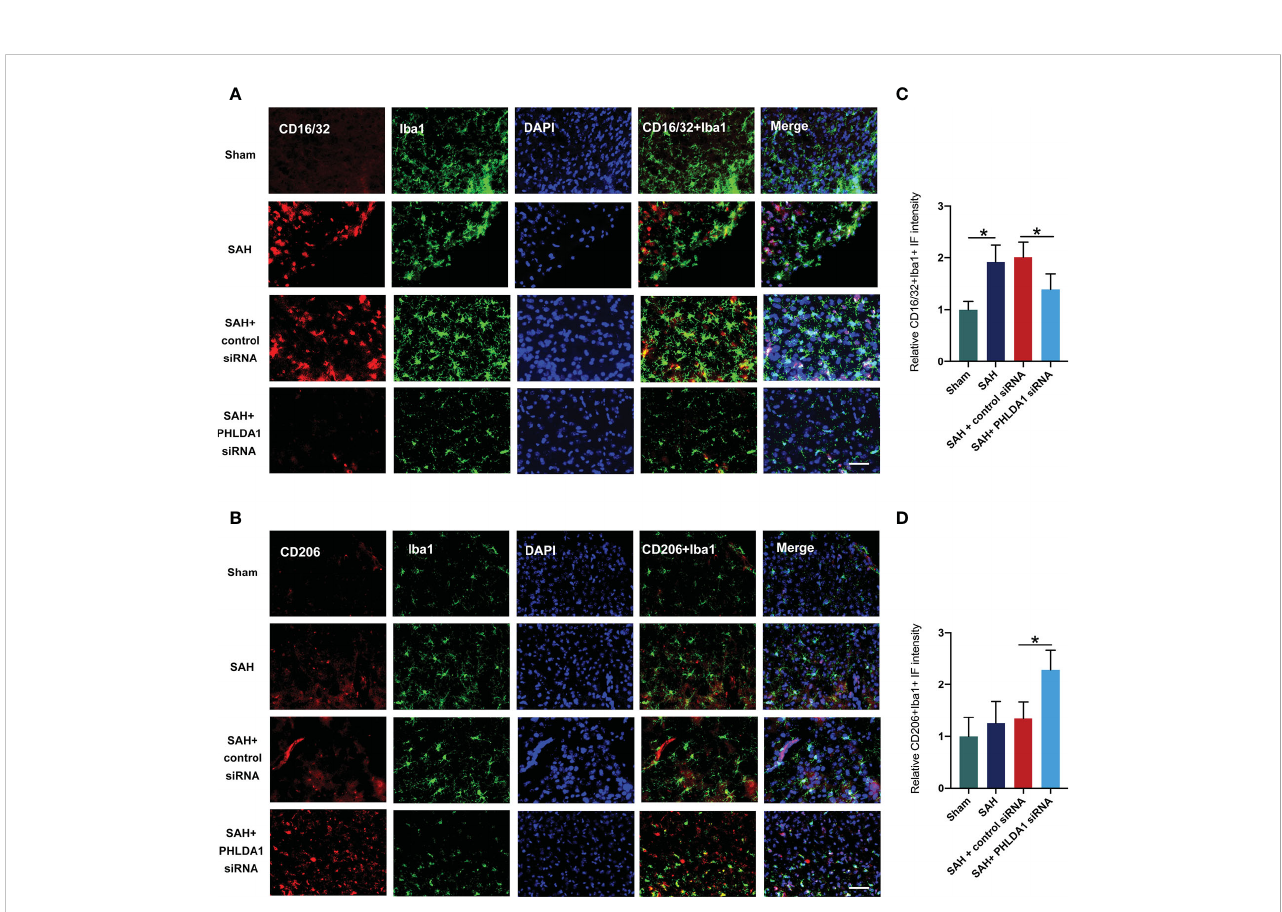
FIGURE 4 PHLDA1 de fi ciency inhibited M1 microglia polarization and promoted M2 microglia transformation. Representative immuno fl uorescence images of CD16/ 32 (A) and CD206 (B) co-localized with Iba1 in temporal cortex. Quanti fi cation of Iba1 + /CD16/32 + cells (C) and Iba1 + /CD206 + (D) cells in temporal cortex (n = 6 per group). * P < 0.05. Scale bar=50 m m. Data are expressed as mean ±